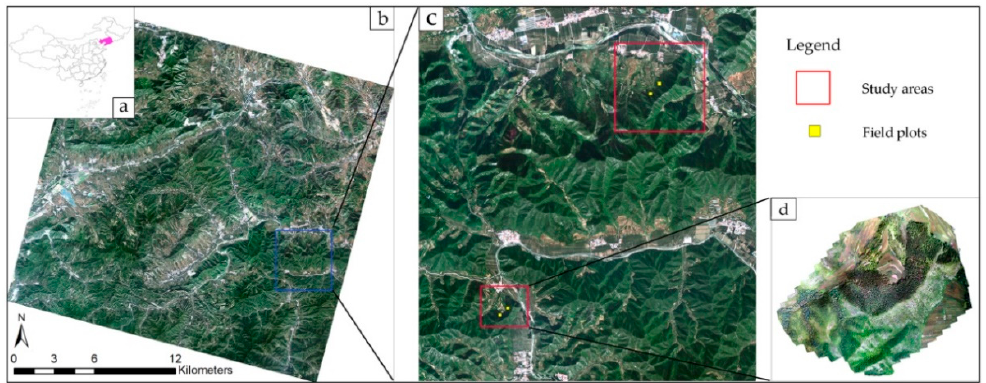
Figure 1. ( a ) Liaoning Province in China; ( b ) true-color Gaofen-2 (GF2) image from 2018; ( c ) the study areas and field plots in the right and left corner of the GF2 image; ( d ) unmanned aerial vehicle (UAV) images in one of the study